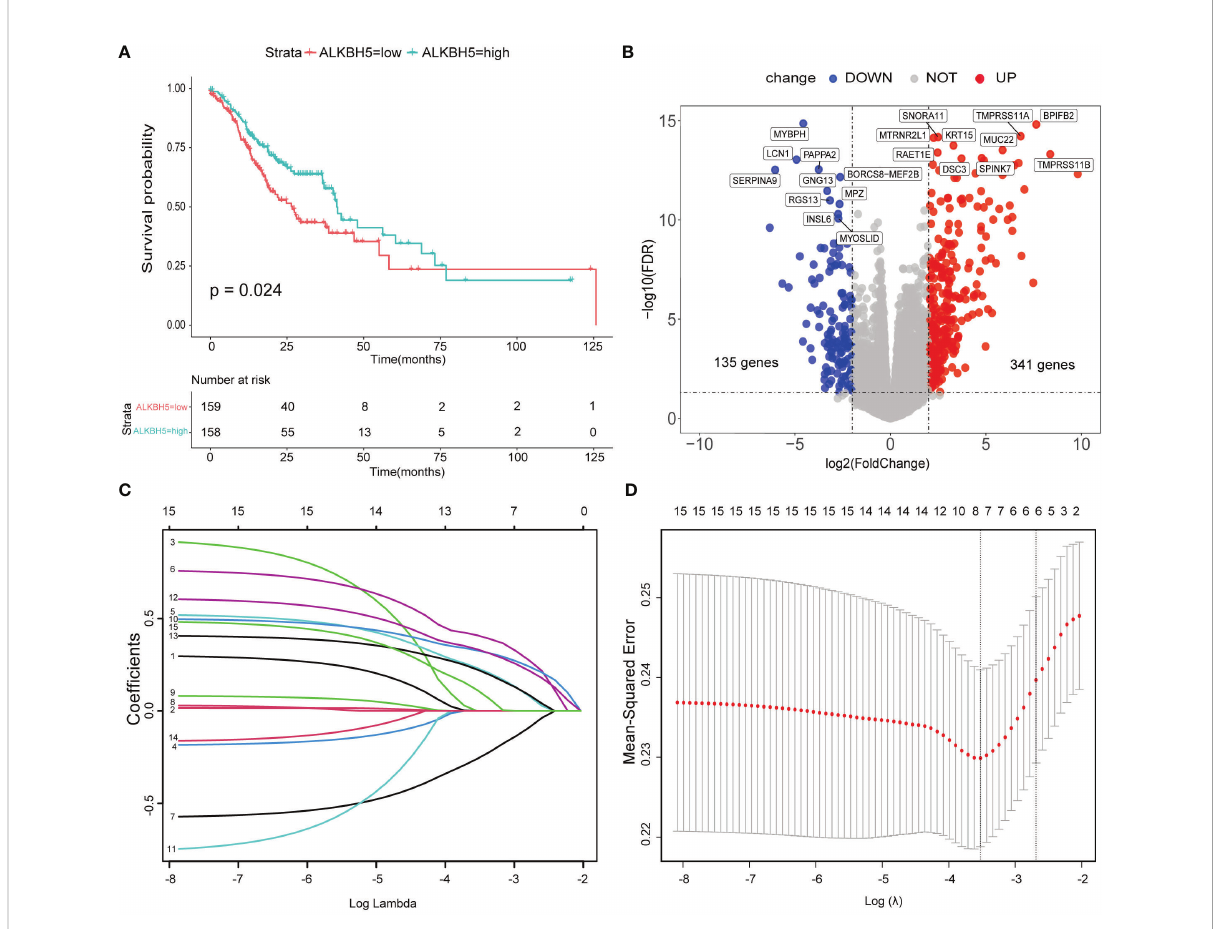
FIGURE 3 A risk model based on ALKBH5-related genes was conducted. (A) Overall survival (OS) of ALKBH5-low and ALKBH5-high subgroups. (B) The differential expression genes (DEGs) between ALKBH5-low and ALKBH5-high subgroups in the training dataset. Red points: upregulated genes in the ALKBH5-high subgroup, blue points: downregulated genes in ALKBH5 -high subgroup. The top 10 upregulated genes and downregulated genes are also shown. (C) The least absolute shrinkage and selection operator (LASSO) coef fi cient of 15 signi fi cant DEGs (P< 0.05) in the univariate Cox regression model with all of the DEGs. (D) Selecting the best lambda parameters for the LASSO